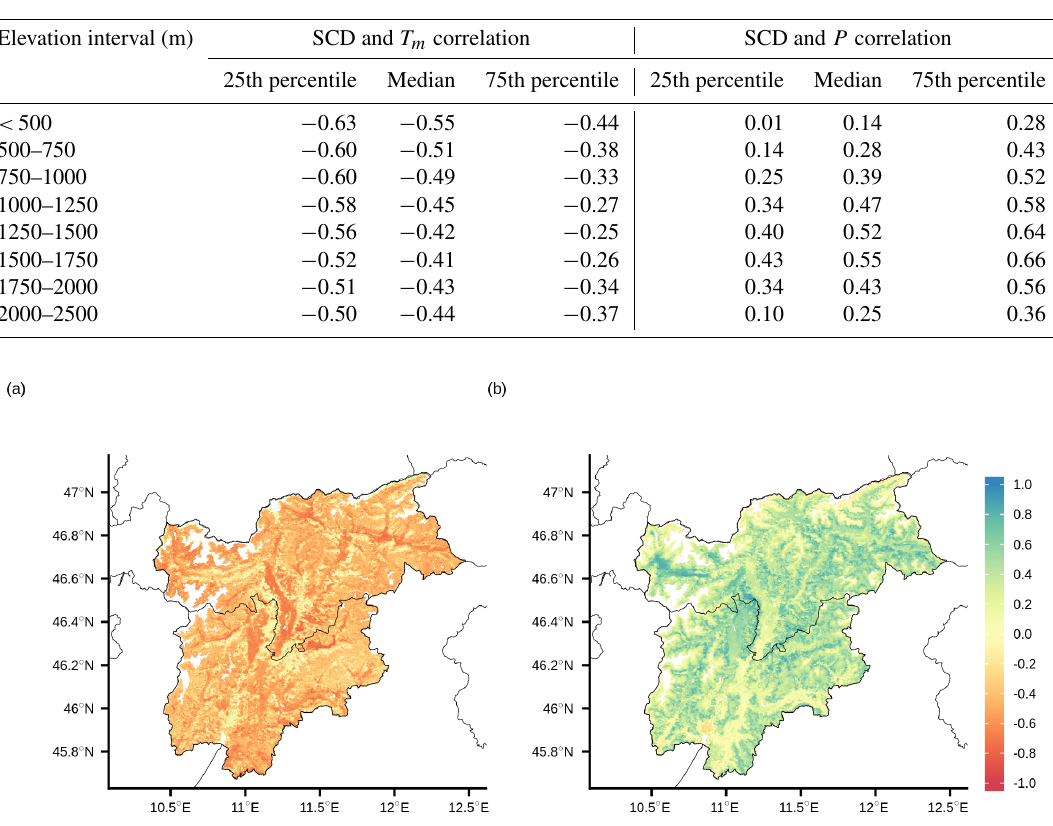
Figure 13. Spatial distribution of 2001–2018 correlation coefficients over the region between SCD (snow-cover duration) and (a) mean temperature and (b) total precipitation in the winter season (December, January and February). White areas correspond to masked grid points (above 2500m) or to missing snow-cover